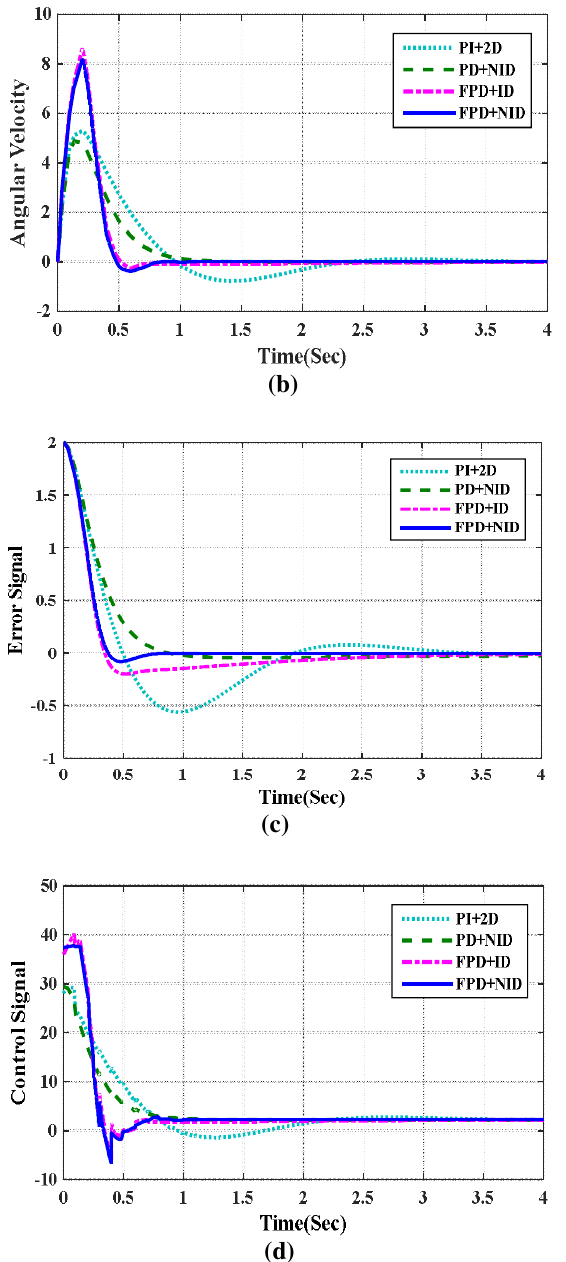
Fig. 10. Simulation results for robotic leg controlled by (PI+2D, PD+NID, FPD+ID, FPD+NID) with step input of mag.2: (a) angular position; (b) angular velocity; (c) error signal; (d) control signal ii.